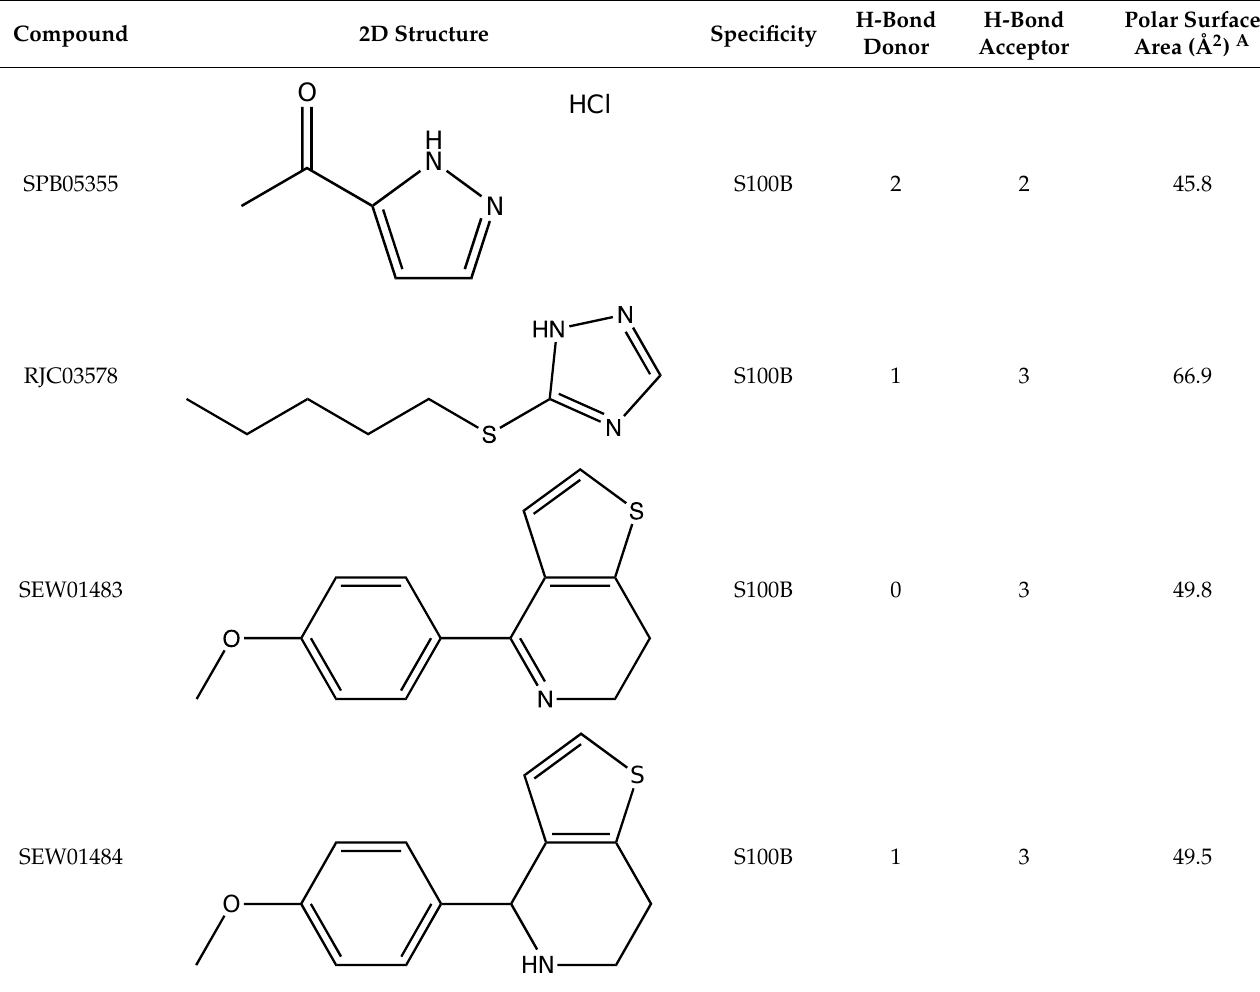
Table 2. Chemical properties of fragments that bind to either S100B or S100A1 specifically and a representative fragment (BTB10184) that binds to both proteins.